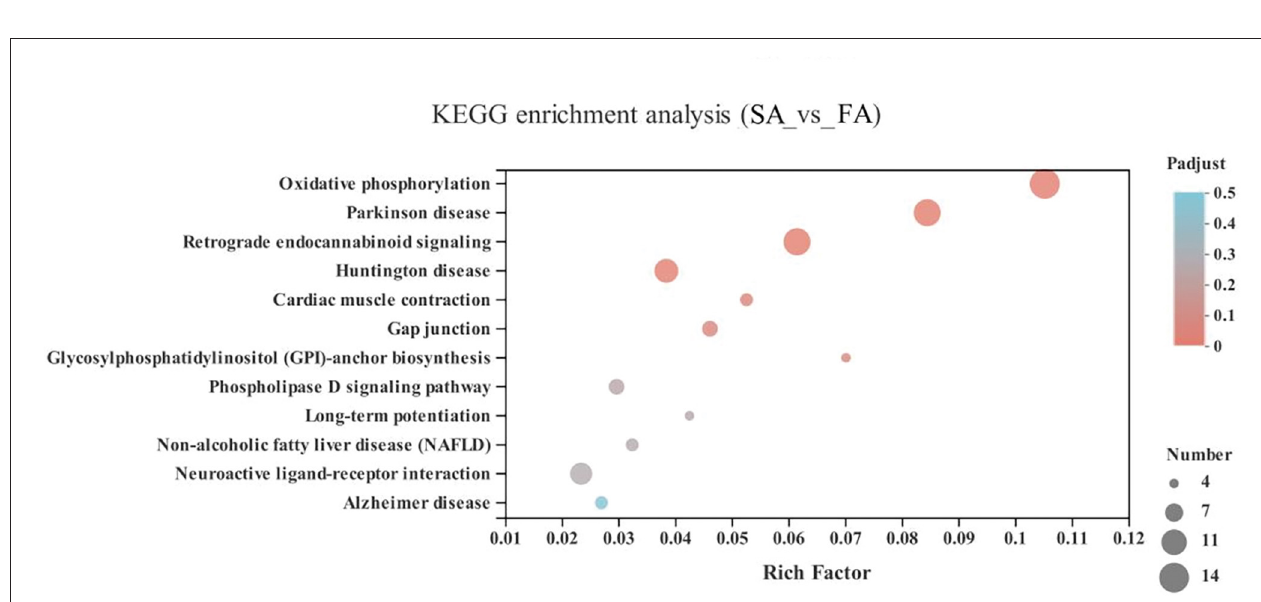
FIGURE 6 | KEGG pathway enrichment analysis of differentially expressed genes (DEGs) between SA and FA groups. SA, slow-growing dual-purpose chickens ad libitum ; FA, fast-growing broilers ad libitum .